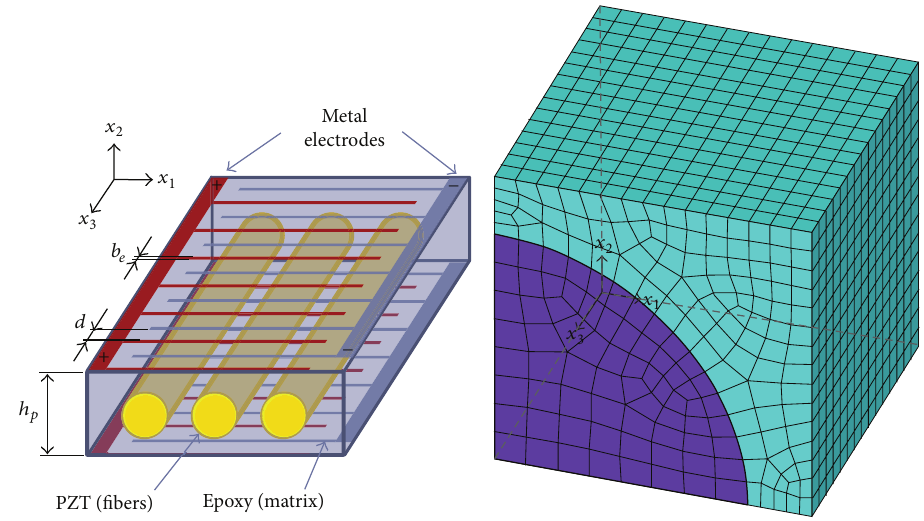
Figure 1: Schematic of the active-fiber composite and its RVE.